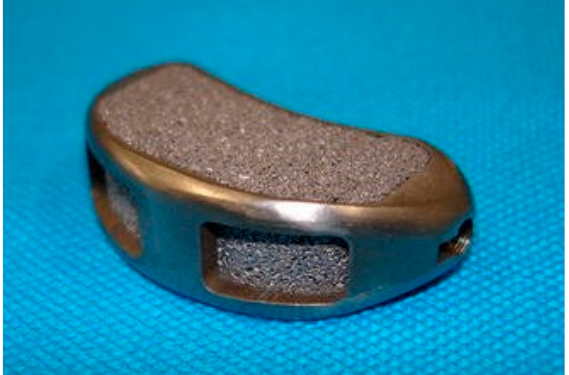
Figure 11. Photograph of porous bioactive titanium device for transforaminal lumbar interbody fusion. Reprinted with permission from Ref. [172]. Copyright 2011, copyright Fujibayashi S, Takemoto M, Neo M, Matsushita T, Kokubo T, Doi K, Ito T, Shimizu A, Nakamura T.